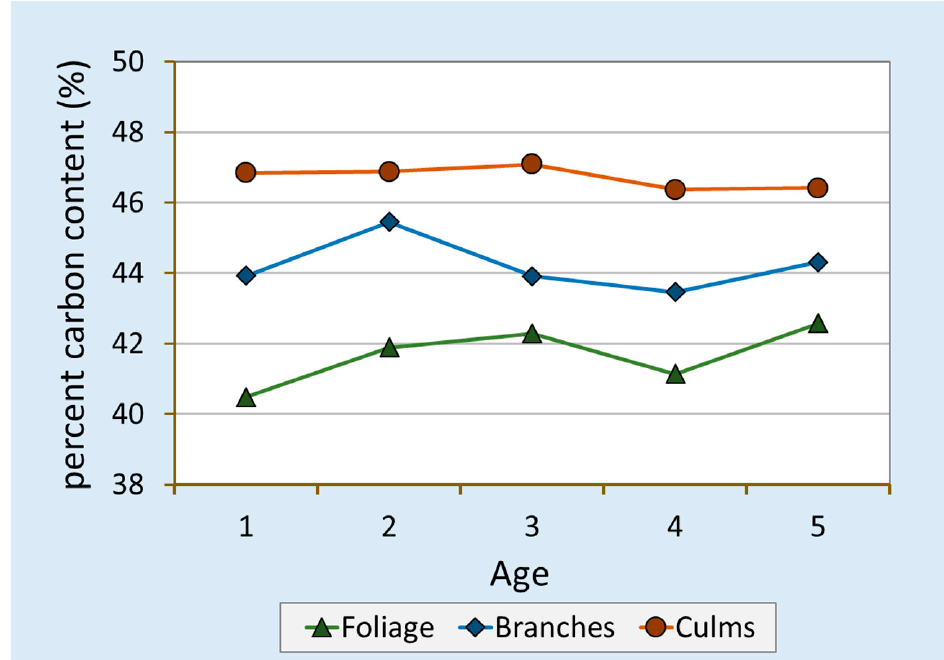
Figure 3. Percent carbon contents of foliage, branches and culms of Ma bamboo of different ages.